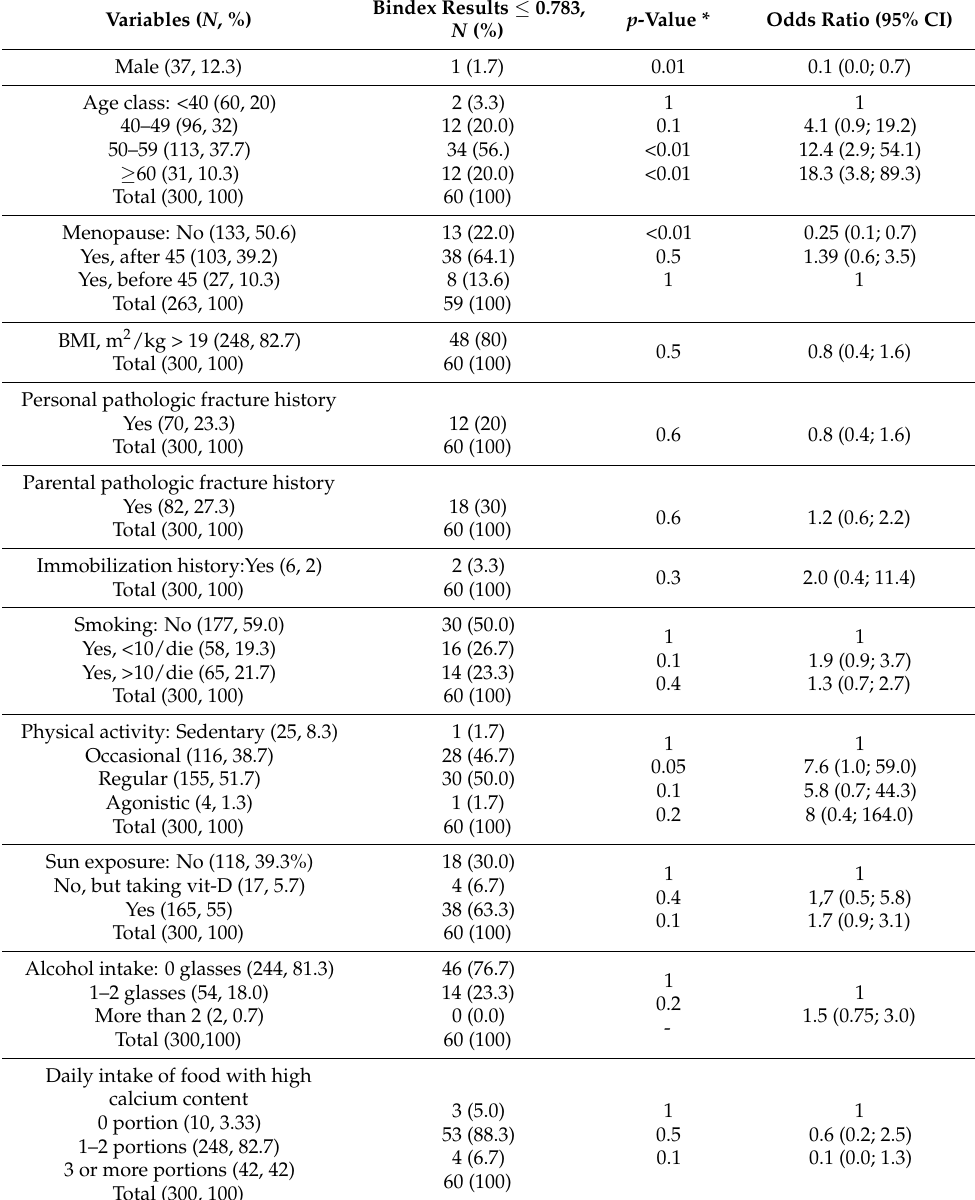
Table 2. Total population features; associations between bone loss (0.783 g/cm 2 ) and osteoporosis risk